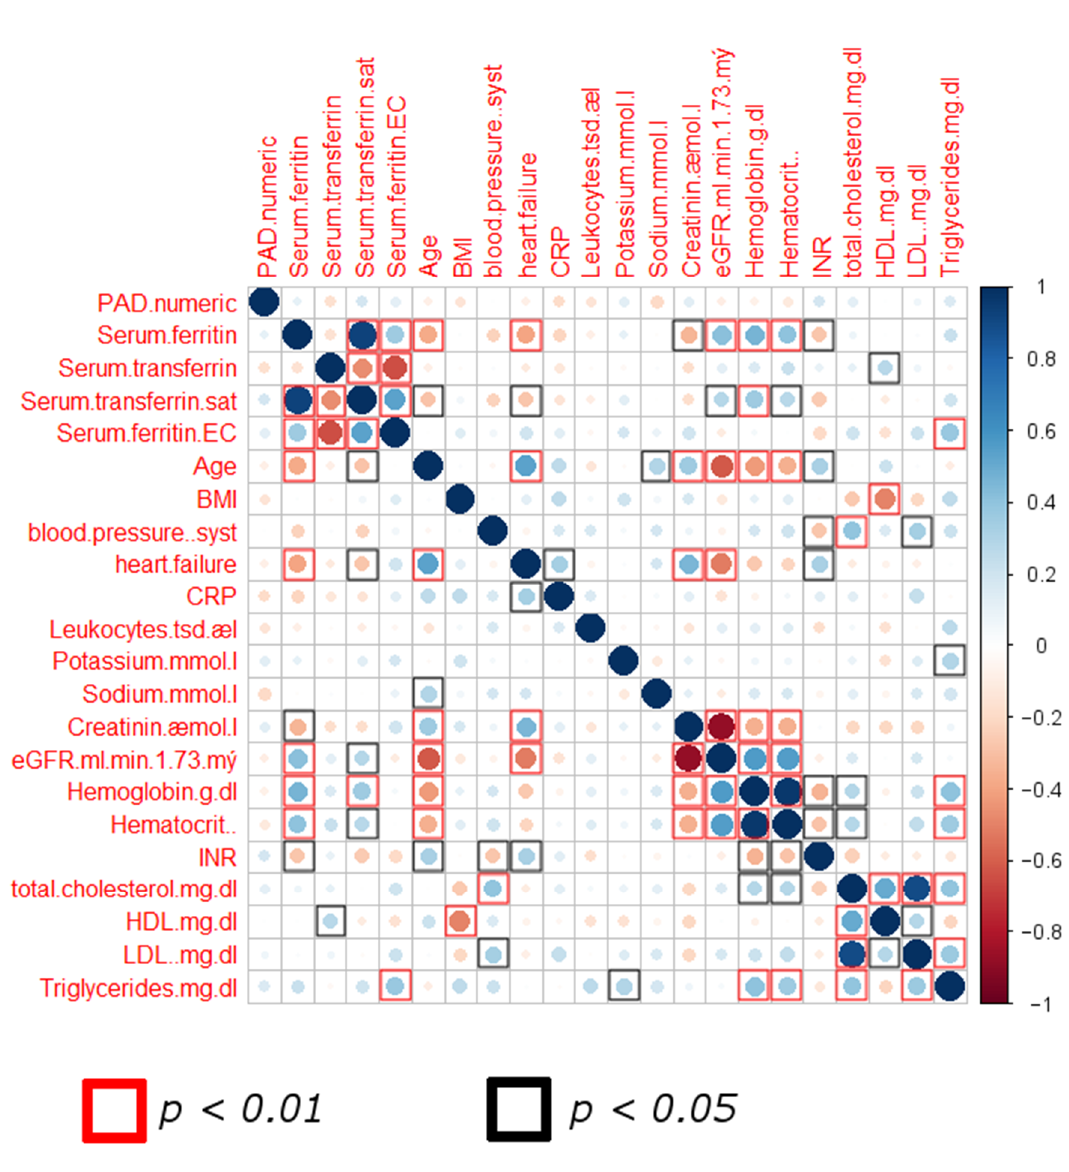
Figure 1. Correlation matrix screening of pooled data from both patient groups. Scale displays Spearman correlation (r) values. (Abbreviations: sat: saturation; BMI: body mass index; CRP: C-reactive protein; INR: International Normalized Ratio; p -value < 0.05 as significance level).